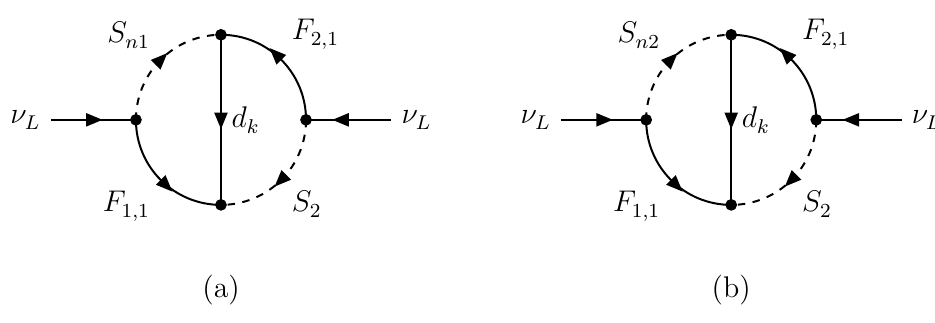
Figure 11 . The diagrams for the neutrino mass generation in the model W-2-5-4-1-3-35, which is mediated by the fields of the 0 νββ decay model N1-1-6-1-4-1-11, where d k with k = 1 , 2 , 3 stand for the down quark, strange quark and bottom quark